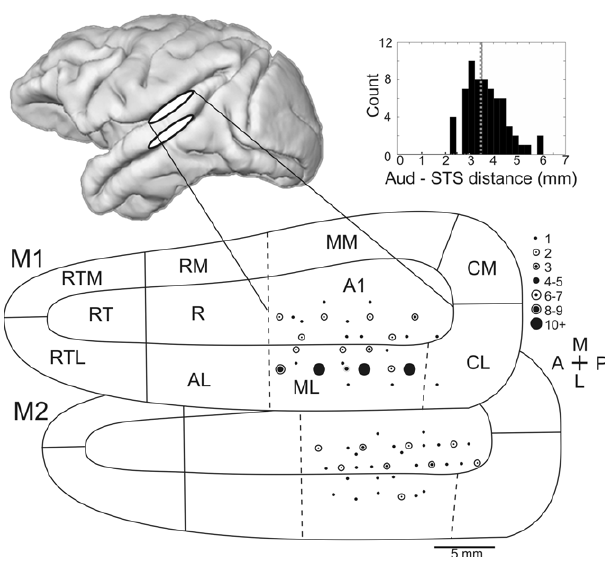
Figure 2. Recording sites in auditory cortex. Approximate recording locations for the auditory cortex (top white ellipse) and the superior temporal sulcus (lower white ellipse) shown on the lateral view of a macaque brain rendered from an MR image. Flattening the surface of the lower bank of the lateral sulcus, the relative positions of auditory cortex regions can be seen (adapted from Kaas and Hackett, 2000). The top and bottom maps show electrode locations for monkey 1 and monkey 2, respectively. The number of times that a recording location was sampled is indicated by the size of the dot. Dotted lines indicate anatomical boundaries that have no discrete func- tional boundary (e.g., tonotopic reversals between A1 and R) and therefore could not be determined from the functional mapping. Inset: histogram of distances between auditory cortex and the superior temporal sulcus. The mean distance is indicated by a dotted line. Abbreviations of cortical areas: AI, auditory area I; R, rostral area;